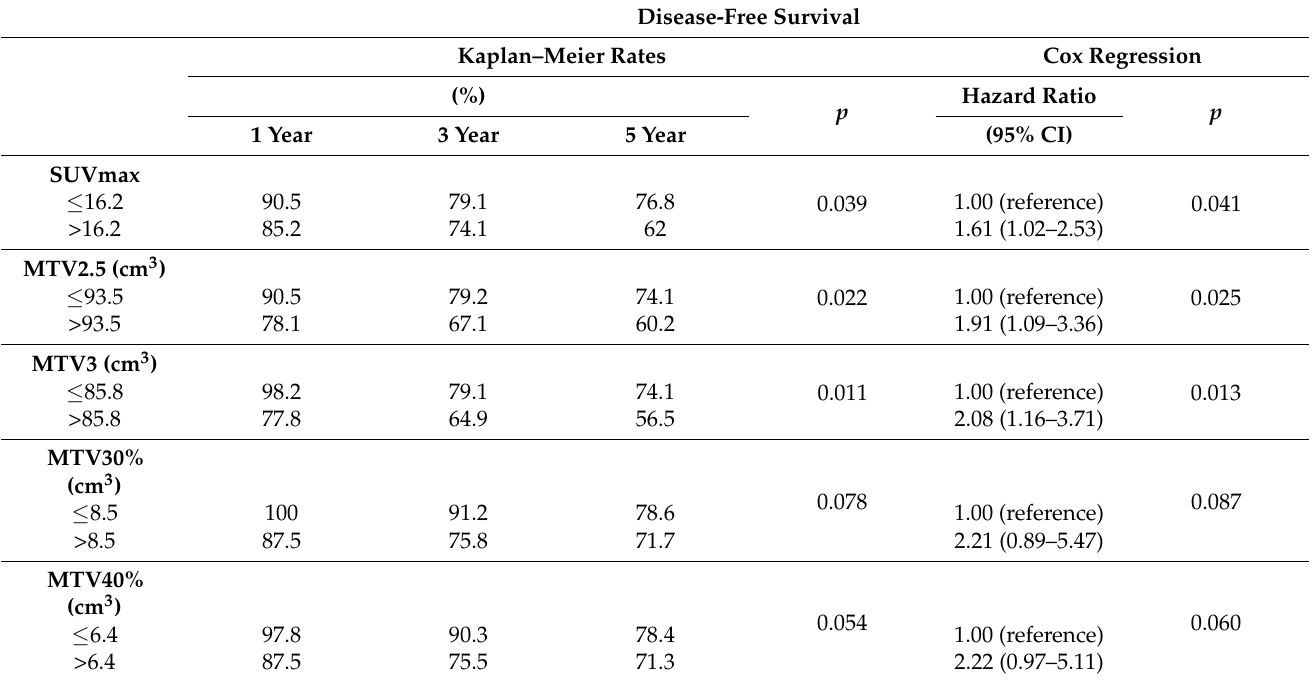
Table 2. Disease-free survival (DFS) rates and hazard ratios for DFS according to cut-off levels for PET